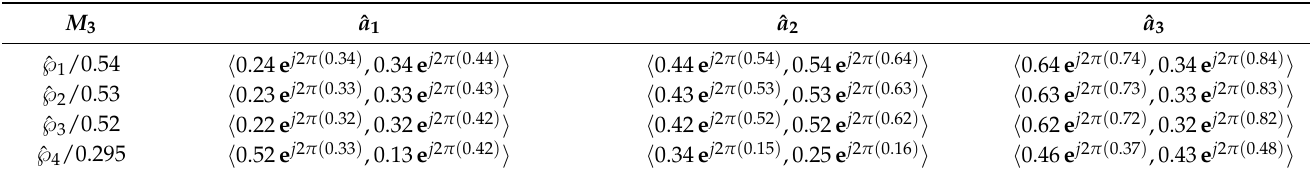
constructed with Dm 3 . Dm 3